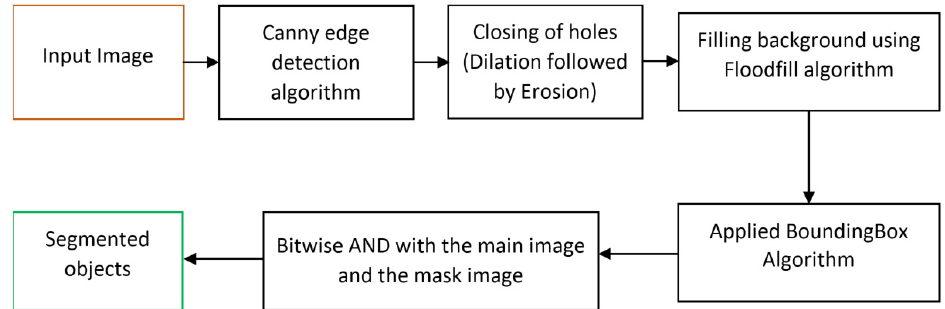
Figure 4. Proposed unsupervised segmentation method flow diagram.